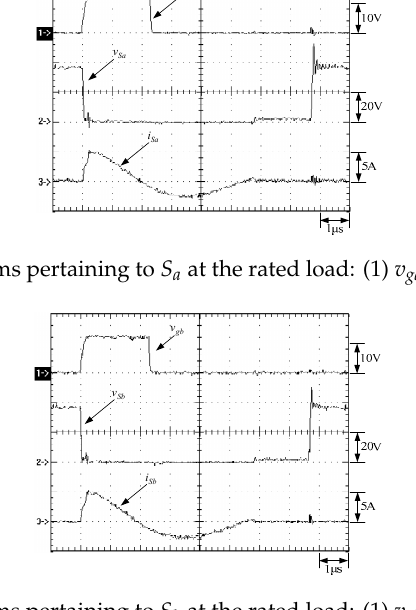
Appl. Sci. 2019 , 9 , x FOR PEER REVIEW Figure 33. Waveforms pertaining to S b at the rated load: (1) v gb ; (2) v Sb ; and (3) i Sb .